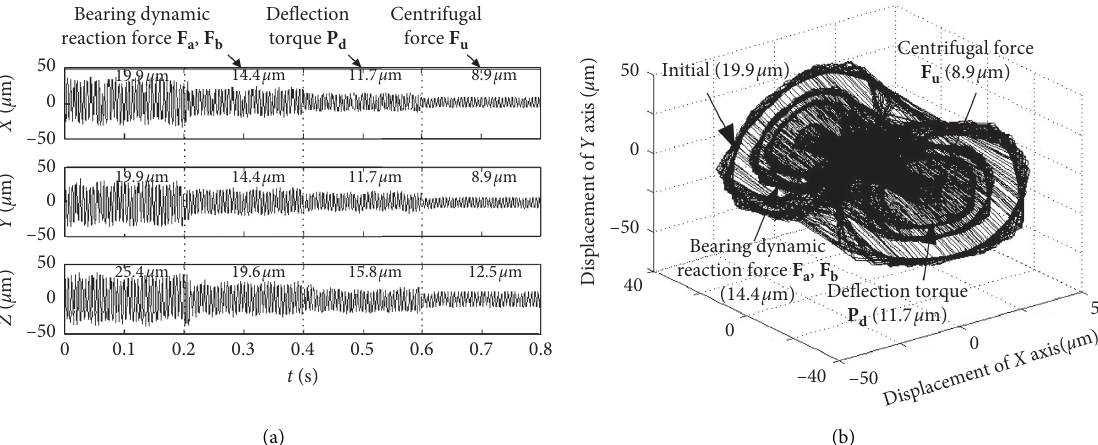
Figure 8: Experiment results with feedforward compensation: (a) the vibration displacement and (b) the rotor vibration